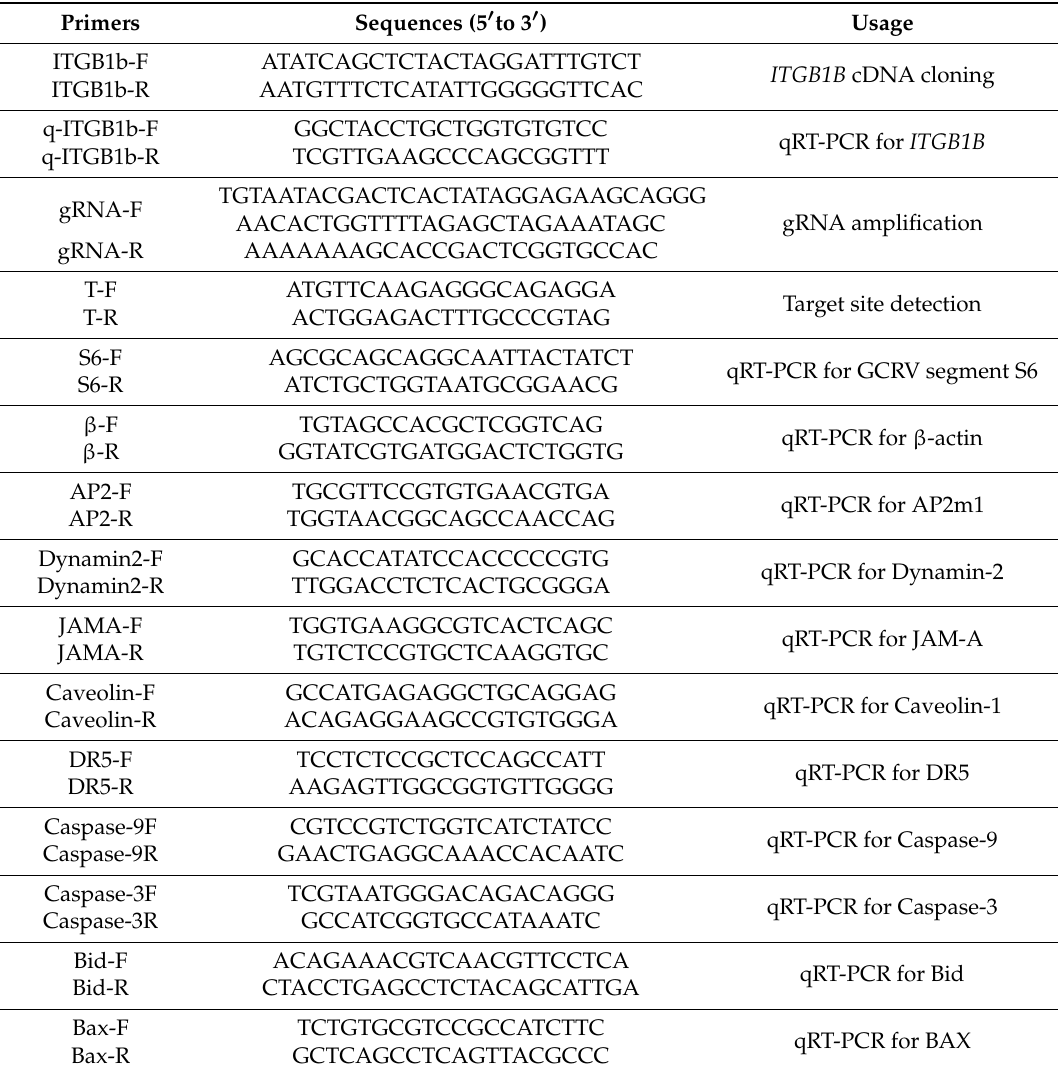
Table 1. Sequences of primers used in the